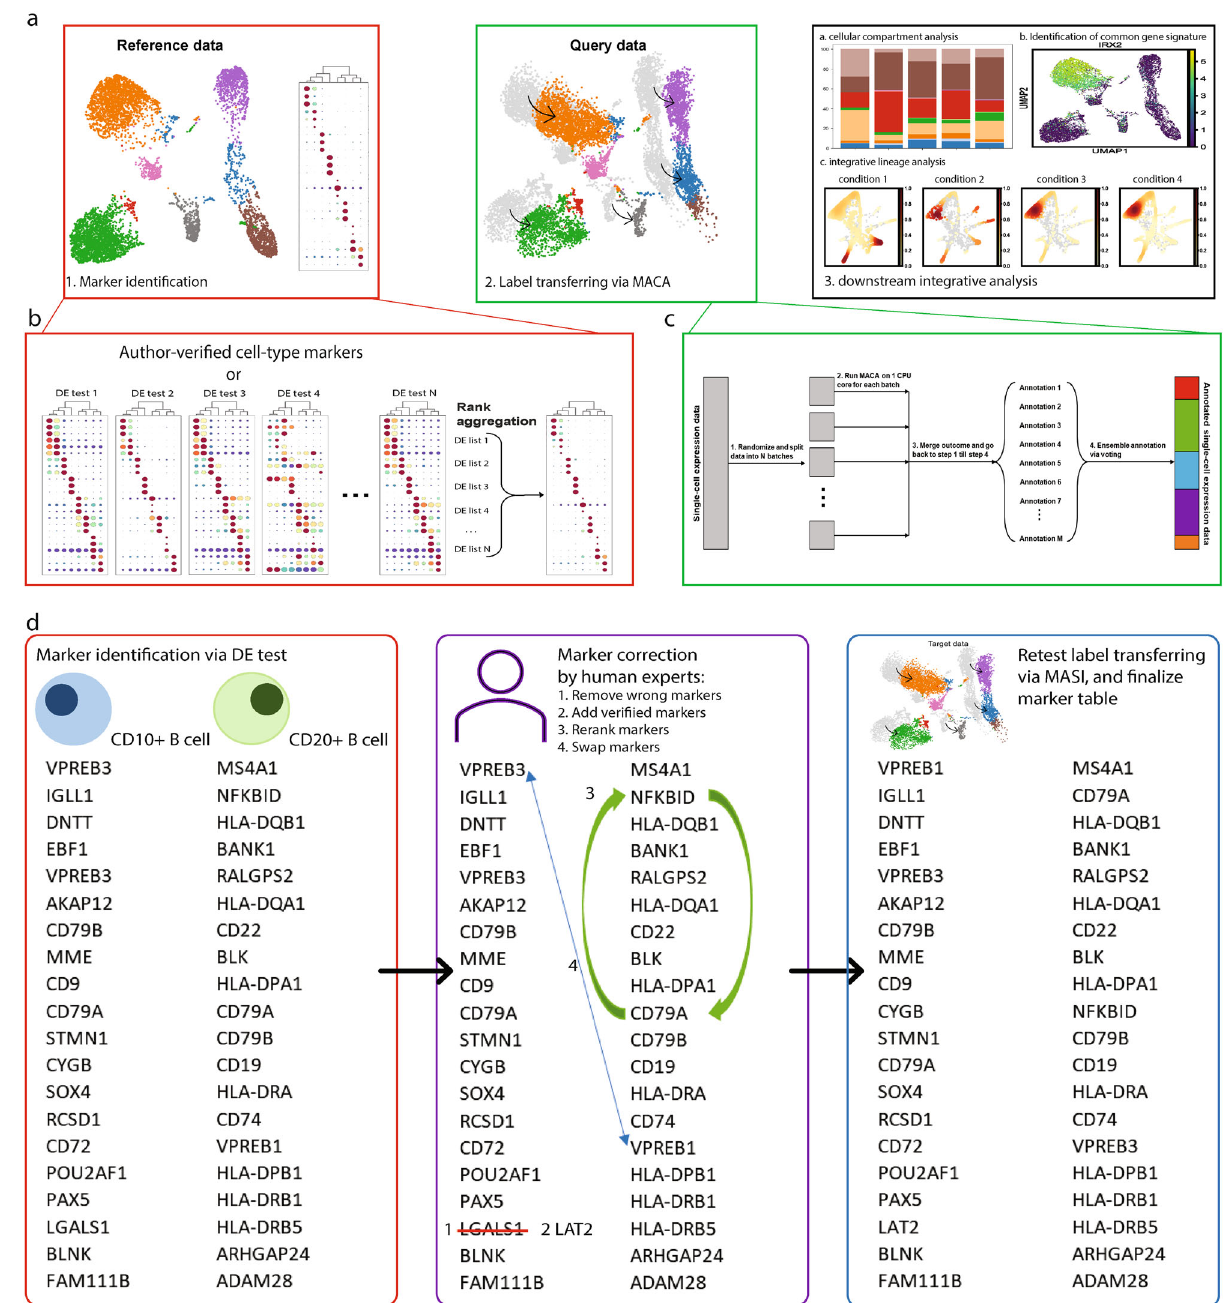
Fig. 2 Integrative annotation pipeline through MASI. a A work fl ow of integrative annotation through MASI, including marker identi fi cation from reference data, label transferring by MACA, and downstream integrative analyses. b Ensemble approach to identify robust cell-type markers from reference data. N DE test outcomes are aggregated to get the fi nal ranked marker list. c Parallel computation for fast annotation in order to accommodate large-scale scRNA- seq data. d Suggested actions for improvement of label transferring. Human experts can correct wrong markers, adjust marker ranking, and so on, in order to improve annotation accuracy by